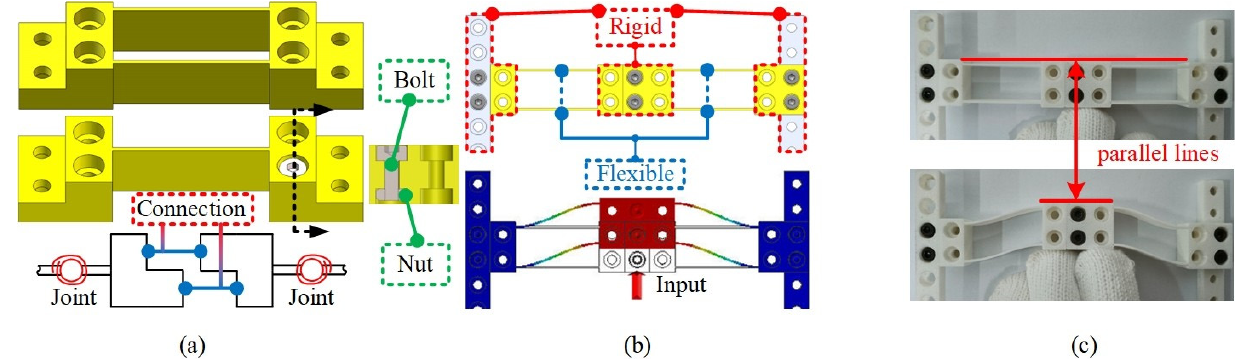
Figure 5. Schematic of bolt connection: ( a ) module with standard interface; ( b ) the connection method; ( c ) simulation of assembled transmission modules.